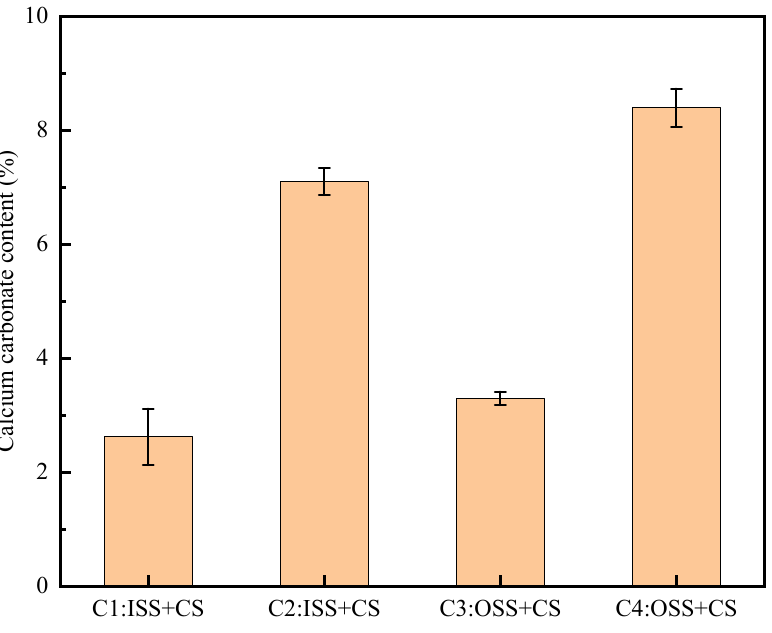
Figure 9. Calcium carbonate contents of samples.